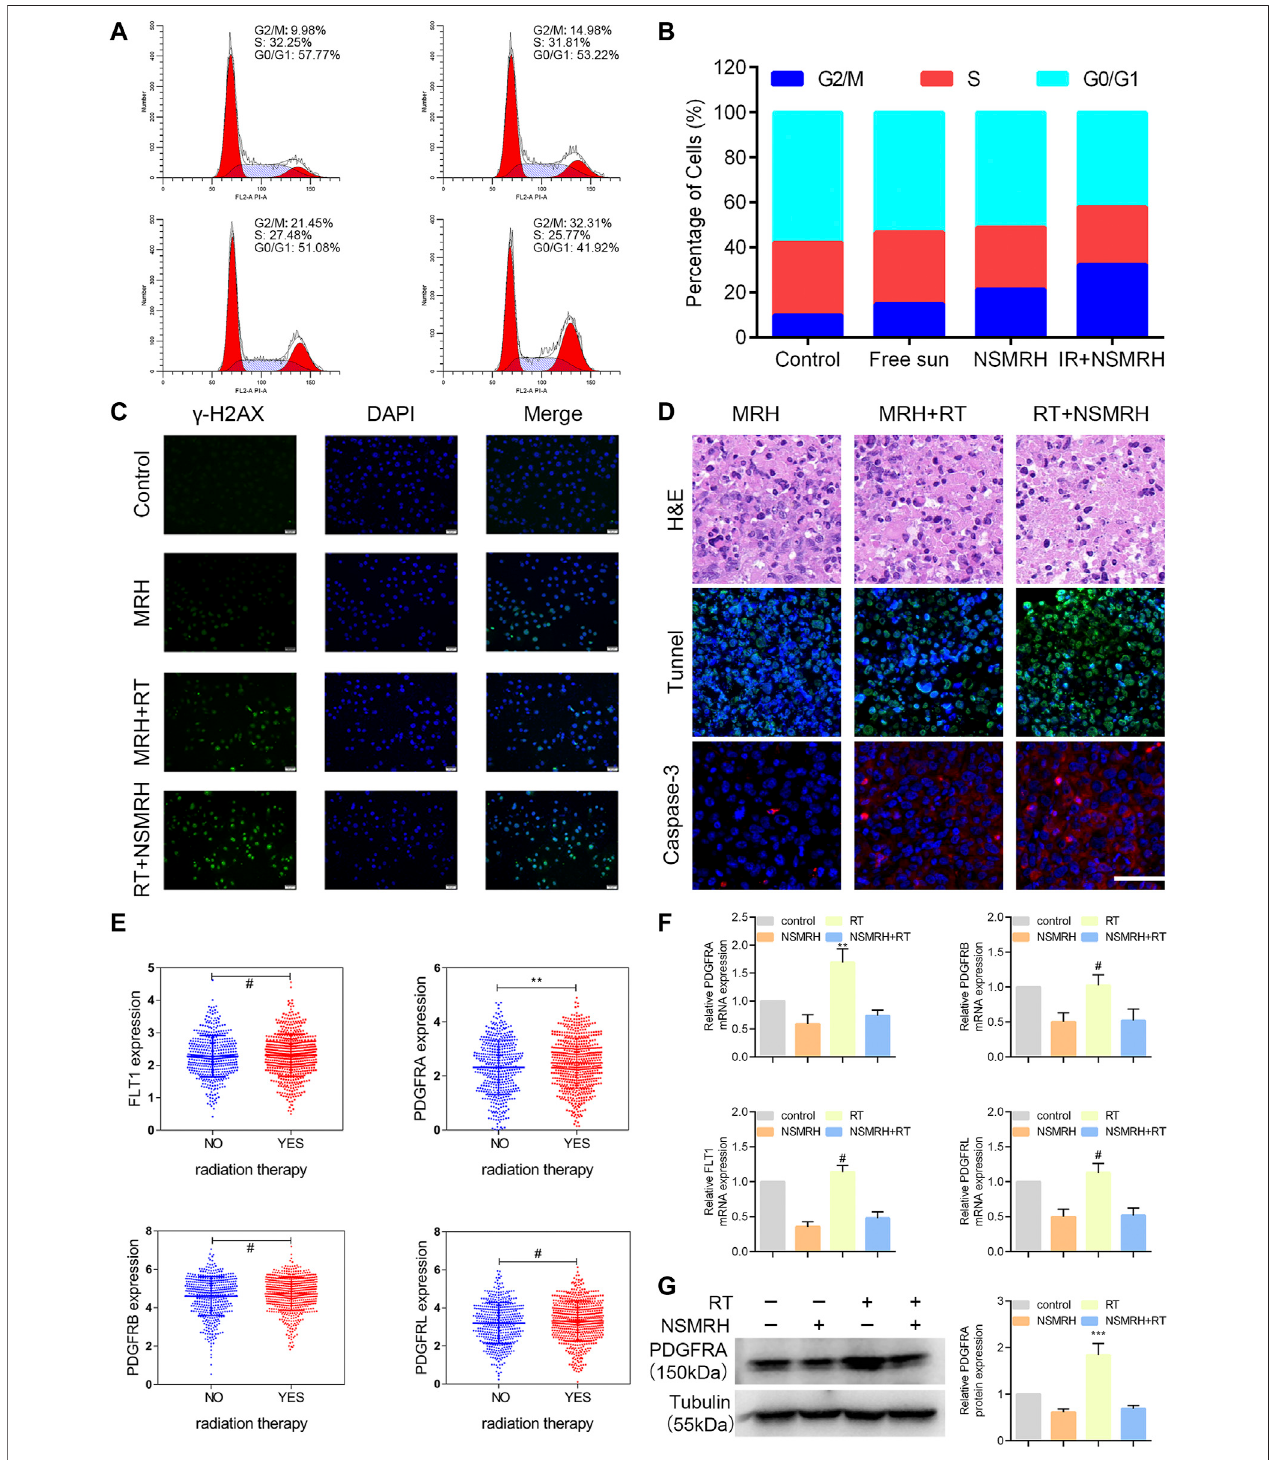
FIGURE5| AnalysisofthepossiblemechanismofNSMRH. (A,B) NSMRHcombinedwithRTinducesG2/McheckpointofMM-231cells.FFlowcytometricanalysis of the DNA content in four groups cultured for 24 h. Pictures were representative fl ow cytometry plots of three experiments. (C) NSMRH impairs DSB repair after irradiation in MM-231 cells. DSB repair assay was performed by counting phospho γ -H2AX foci. DSBs were stained as green and the nuclei as blue, 200 ×, scale bars: 50 μ m. (D) Tunnel and Caspase-3 expression in original orthotopic tumors, as determined by IHC staining analysis. Each inset shows images obtained at × 100magni fi cation,scalebars:25 μ m. (E) ThemRNAlevelofPDGFRA,FLT1,PDGFRB,andPDGFRLwereanalyzedintheTCGAdataset. (F) RelativemRNAexpression of PDGFRA, PDGFRB, FLT1, PDGFRL, and GAPDH was detected using RT-qPCR in different treatments. (G) Left, the protein level of PDGFRA, FLT1, PDGFRB, and PDGFRL were examined by western blot assay; Right, quanti fi cation of the grayscale analysis in three independent experiments.